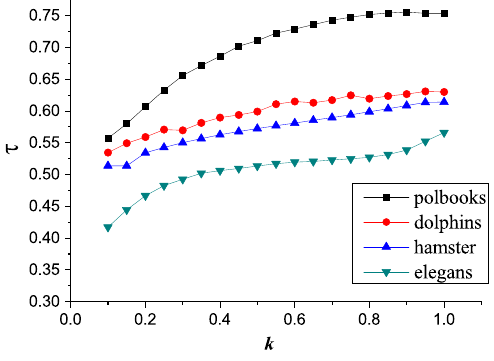
Figure 4. Trend in Kendall coefficient changes with the value of parameter k